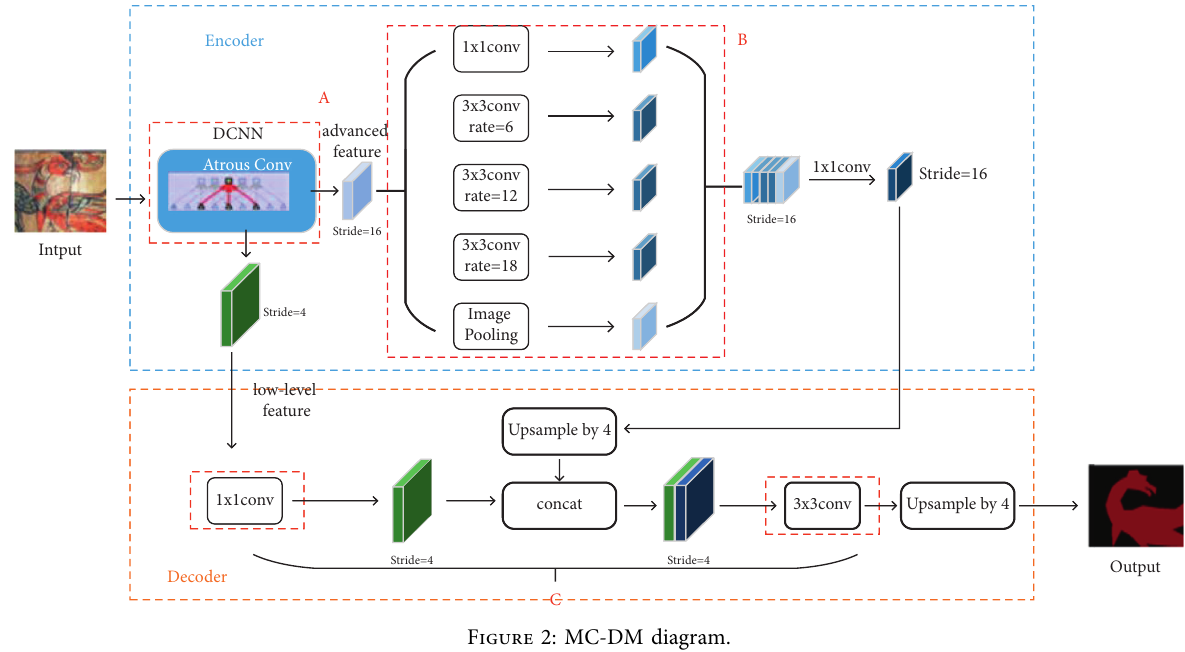
Figure 2: MC-DM diagram.